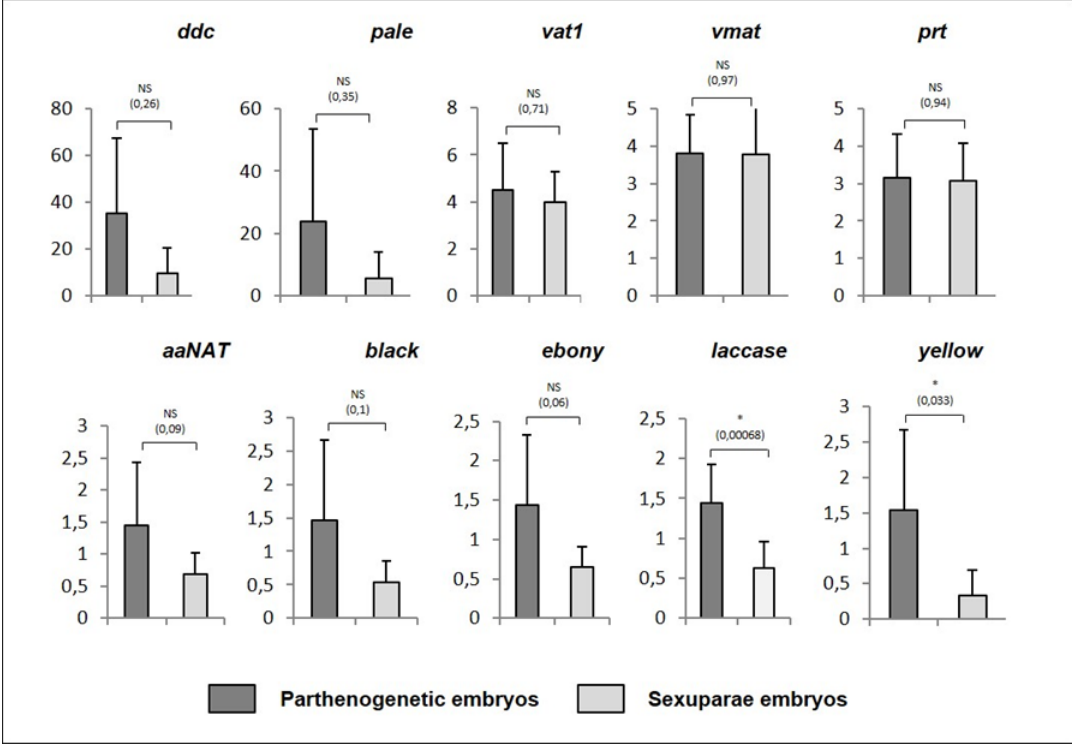
Figure 6 – Expression levels of dopamine pathway genes in virginoparae and sexuparae embryos. Most developed embryos from adult aphids placed under long days (virginoparae embryos) and short days (sexuparae embryos) were collected for the quantification of the level of expression of dopamine pathway genes. Relative quantification was performed using RpL7 as an invariant gene. A t-test was performed to estimate if the genes were significantly regulated between the two conditions (the p-value of the test is indicated between brackets).